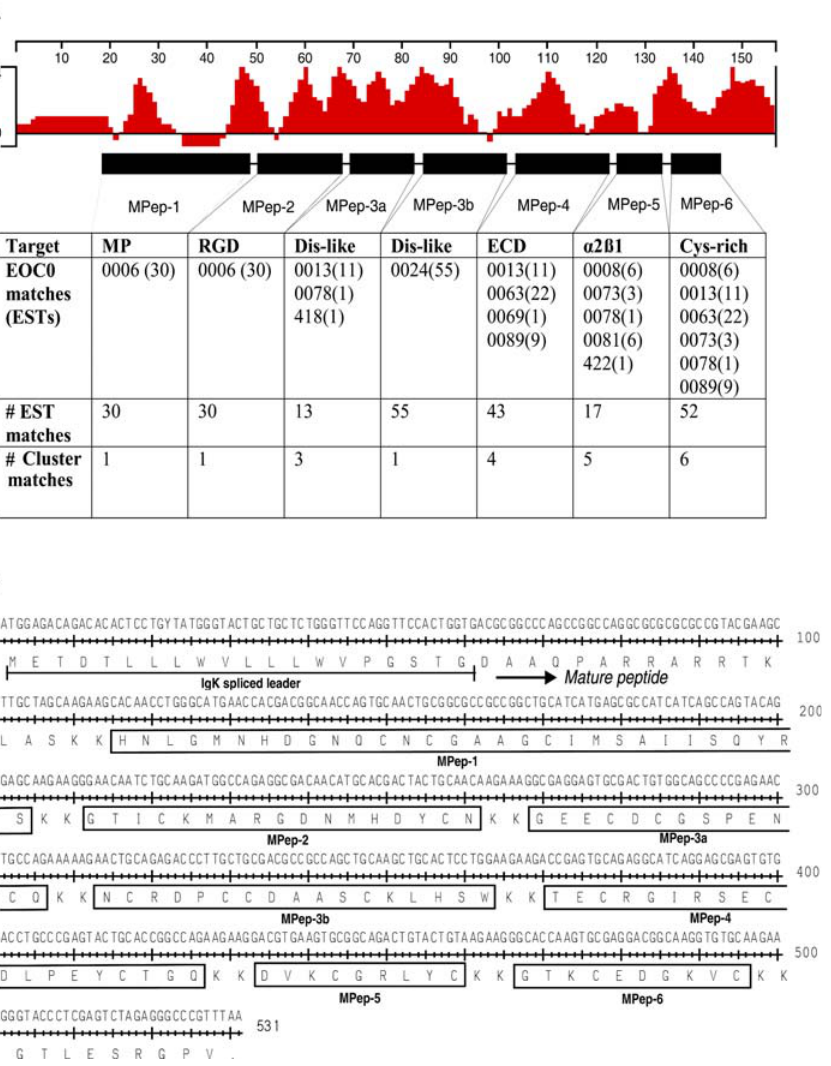
Figure 3. The EoSVMP String (A) Upper graphic: Jameson-Wolf antigenic profiling of the mature EoSVMP string synthetic DNA immunization construct. Lower chart: Target domains for individual MP epitopes. Cluster matches against each peptide are shown. The number of ESTs in each cluster is indicated in parentheses. a 2 b 1, a 2 b 1 integrin-binding motif in Jararhagin-C; Cys-rich, C-terminal region of the cysteine-rich domain; Dis-like, disintegrin-like domain; ECD, ECD motif and flanks; MP, metalloproteinase catalytic domain; RGD, RGD-containing PII and flanking sequences. (B) Complete nucleotide and coding sequence of EoSVMP string. Sequence and locations of epitopes, separated by lysine spacers are indicated. DOI: 10.1371/journal.pmed.0030184.g003